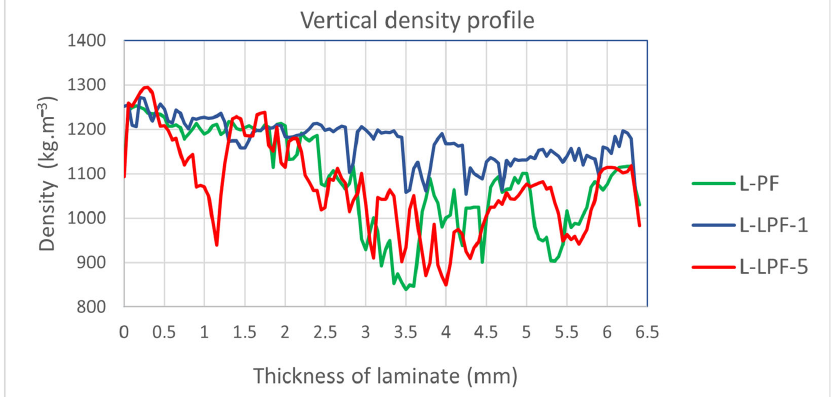
Figure 5. Vertical density profile of produced